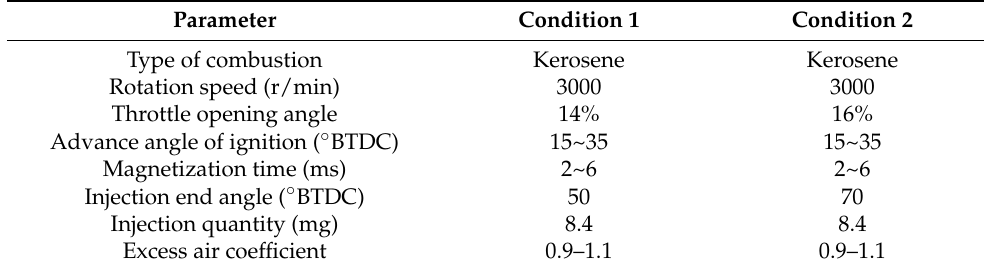
Table 6. Ignition parameters at low load.